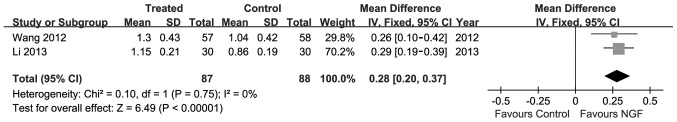
Forest plot of NGF for Bell’s palsy on response rate by electroneurography. SD, standard deviation; NGF, nerve growth factor; CI, confidence interval; IV, inverse variance method.